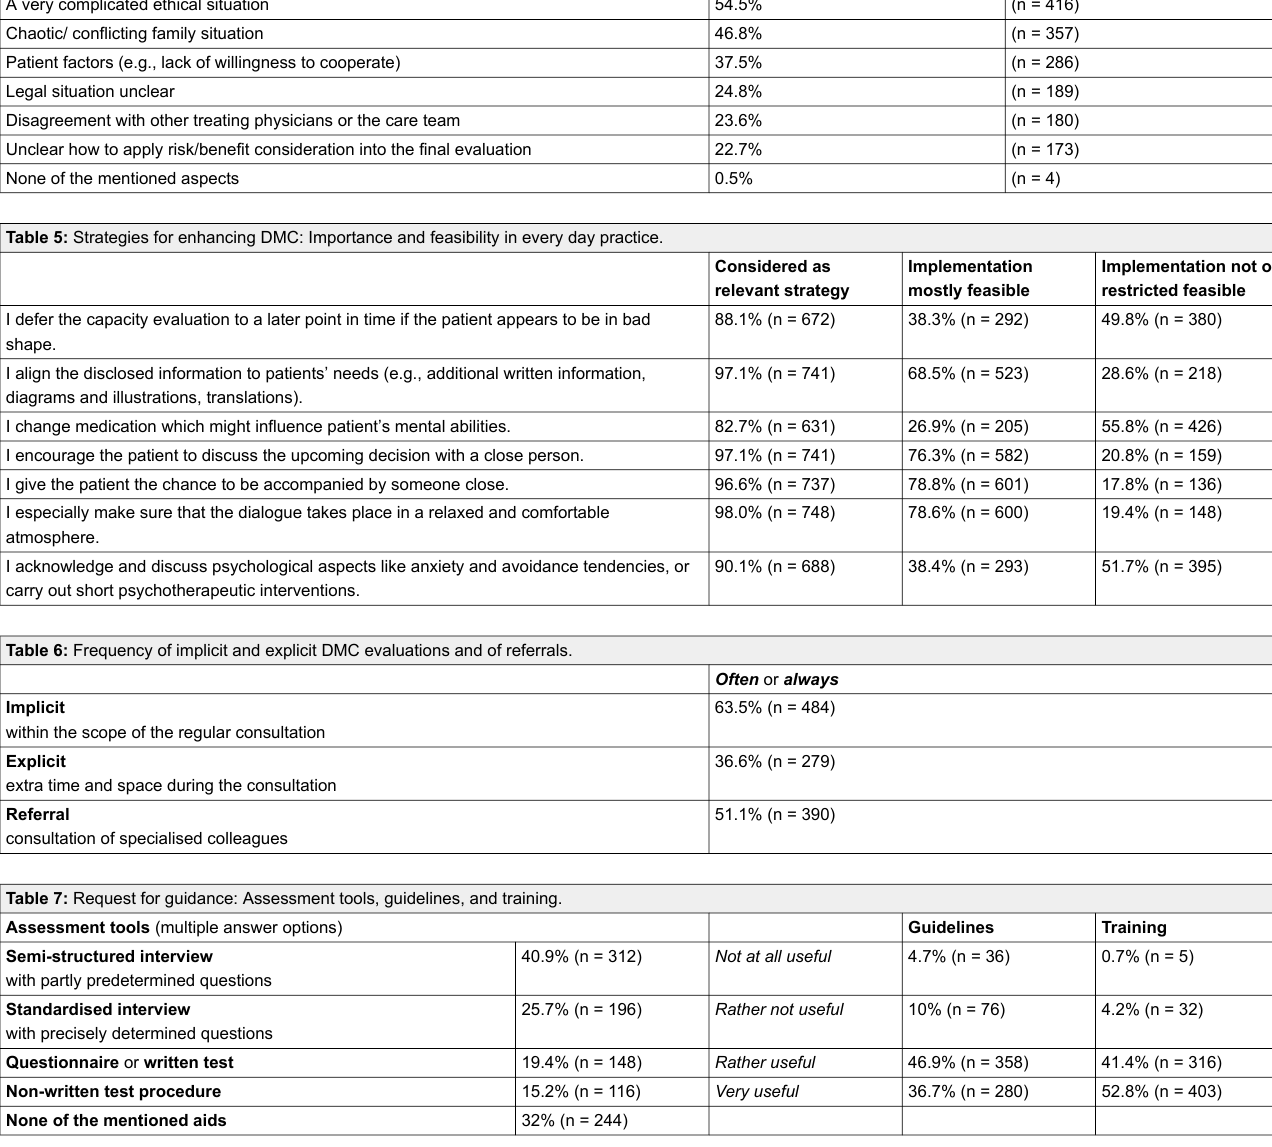
Table 4: Complicating factors in DMC evaluations.